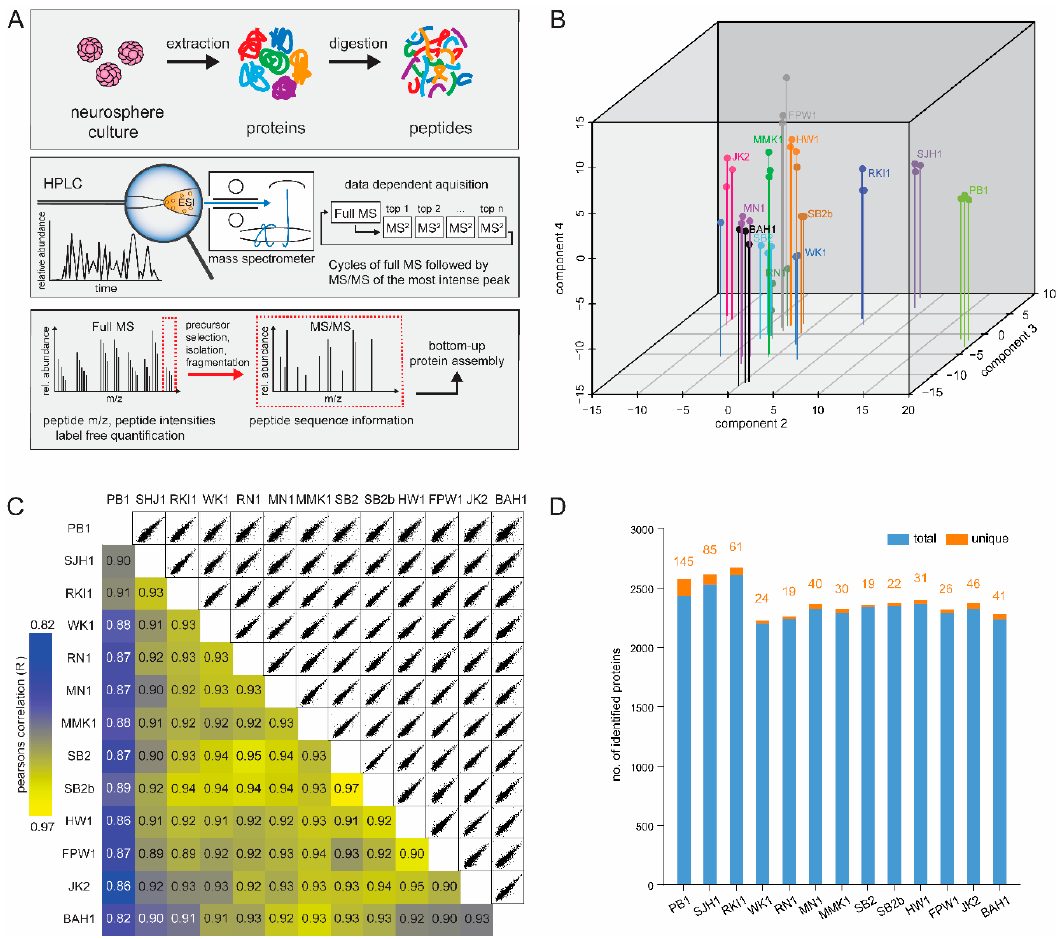
Figure 1. Proteome mapping of 13 Q-cell cell lines. ( A ) Graphical illustration of the workflow for glioblastoma (GBM) cell line proteome analysis. GBM primary cell lines were cultured as neurospheres, lysed in SDS-based buffer, trypsin digested by in-solution digestion in biological triplicate. LC–MS/MS with 4 hour runs and CID fragmentation were performed in the LTQ-Orbitrap Elite. ( B ) 3D-PCA plot. The proteome of thirteen cell lines measured in triplicates segregated into major cell types showing well-correlated triplicates within a cell line. ( C ) The matrix of 78 correlation plots revealed very high correlations between protein intensities in triplicates (Pearson correlation coefficient 0.82–0.97 between cell types). The colour code follows the indicated values of the correlation coefficient. ( D ) A bar chart showing the number of total proteins identified in each of the cell lines with false identification rate (FDR) of 1%.